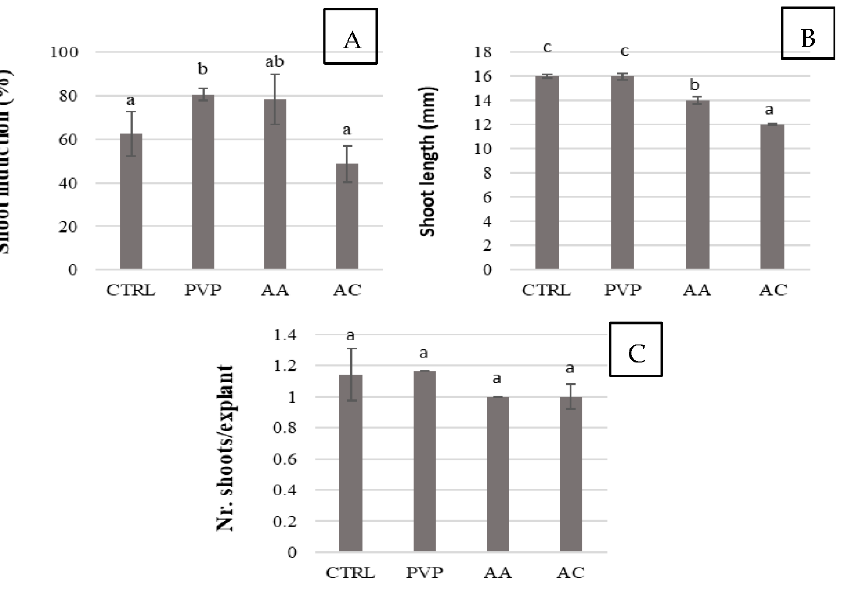
Figure 2. Effect of different polyphenol controlling agents on establishment of chestnut cv. ‘Garrone Rosso’. ( A ) Shoot induction percentage, ( B ) shoot length and ( C ) nr. of shoots per explant. The same results were observed for the cv. ‘Marrone di Castel del Rio’. CTR: control medium, a medium without any polyphenol controlling agents; PVP: 500 mg/L polyvinylpyrrolidone; AA: 100 mg/L ascorbic acid; AC: 1 g/L activated charcoal. Data are the means of three biological replicates (15 nodal explants each) ± SE. Means with the same letter do not significantly differ at p ≤ 0.05 (Tukey’s HSD test).